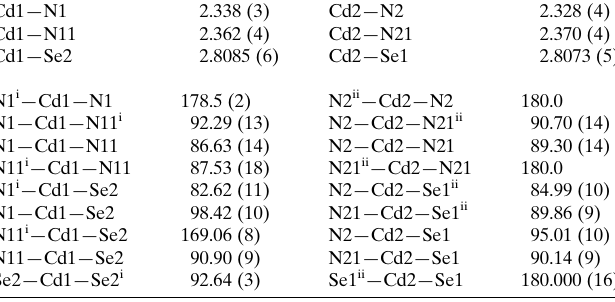
Table 2 Selected geometric parameters (A˚ , (cid:5) ) for 2 .